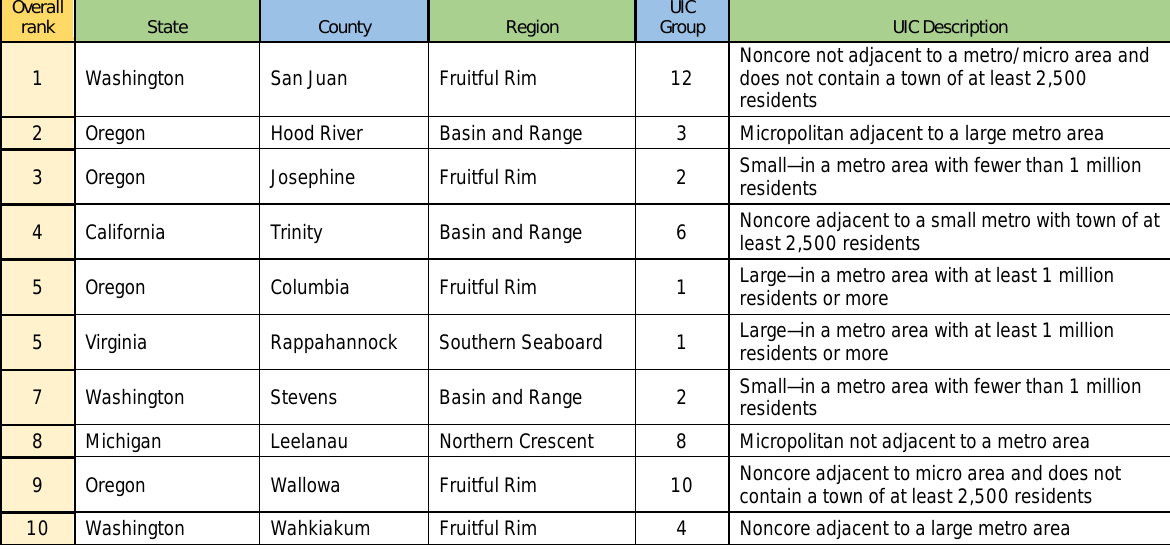
Table 2. EXCERPT FROM Progressive Agriculture Index Top 100 Counties Overall,